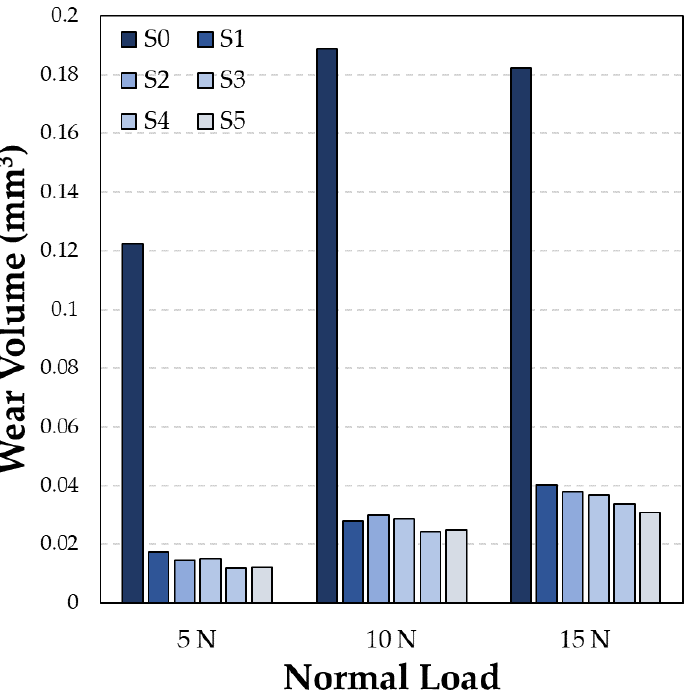
Figure 18. The wear volume of the bulk Al6061 substrate and CS Zr